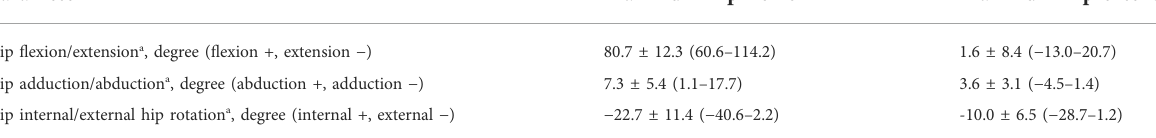
TABLE 2 Hip adduction/abduction and internal/external angles at maximum hip fl exion and extension during